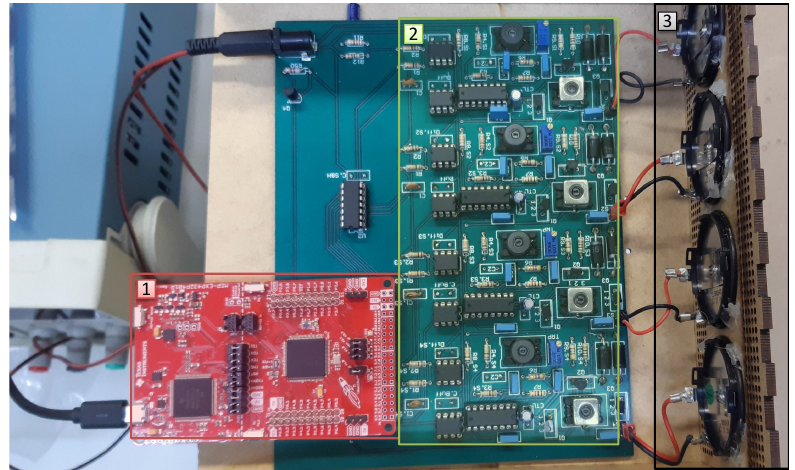
Figure 2. The hardware module designed for ultrasonic wave transmission and